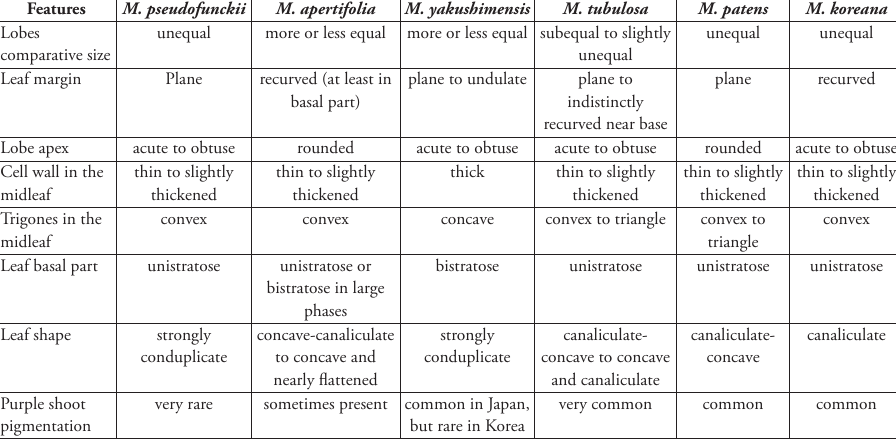
Table 1. Distinction of Marsupella koreana from morphologically similar taxa.